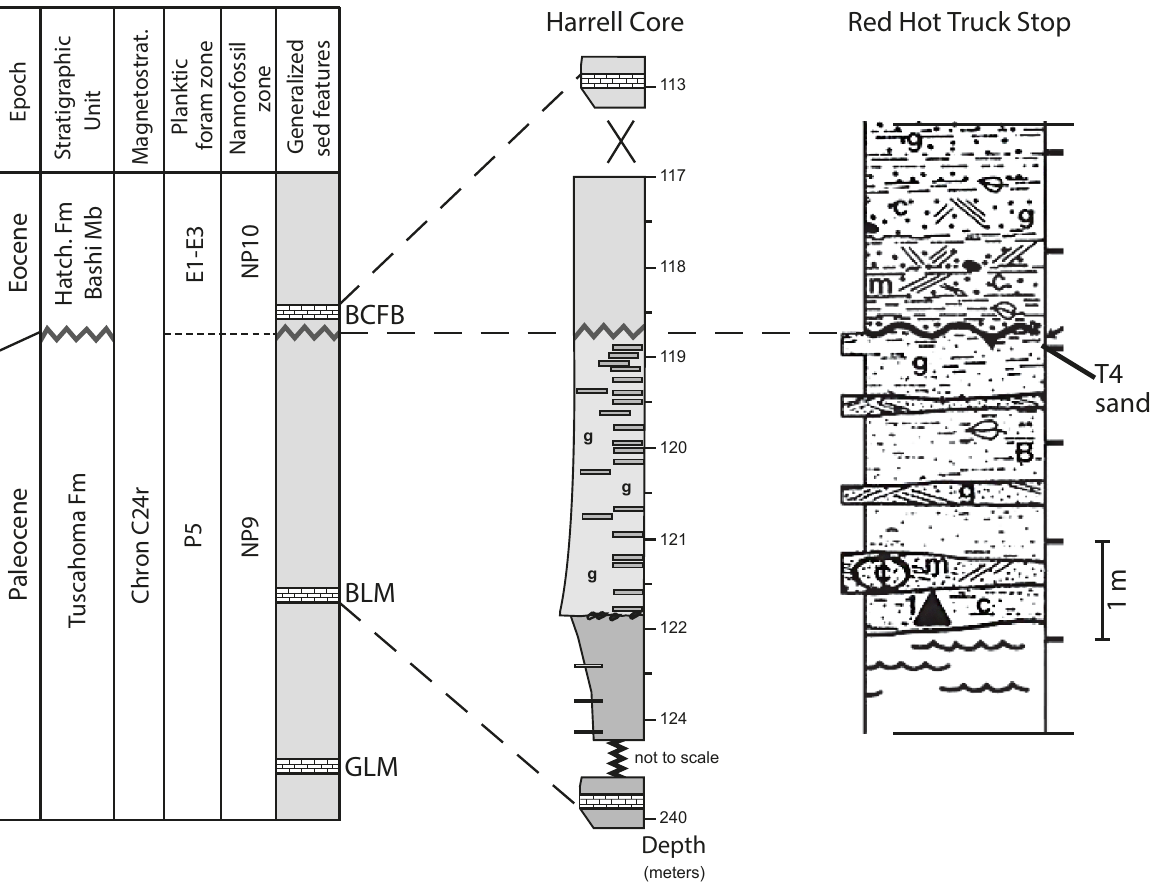
Figure 2. Schematic stratigraphy of upper Paleocene–lower Eocene sediments on the eastern US Gulf Coastal Plain, modified from Har- rington (2003), showing the stratigraphic position of the Red Hot Truck Stop (RHTS) and the Harrell Core. Magnetostratigraphy is from Rhodes et al. (1999), planktic foraminifer zonation of Wade et al. (2011) is based on the data of Mancini and Oliver (1981), and nannoplank- ton zones of Martini (1971) are from Gibson et al. (1982). RHTS log is from Beard and Dawson (2009). Hatch. represents Hatchetigbee; BCFB represents Bashi Calcareous Fossiliferous Bed; BLM represents Bells Landing Marl; GLM represents Greggs Landing Marl; g rep- resents glauconite; dark gray lithology represents brown, gray siltstone/mudstone; light gray lithology represents glauconitic siltstone and fine sandstone; small dark gray boxes within siltstone represent the presence of fine mud layers throughout; and rounded symbols at base of glauconitic unit represent coarse